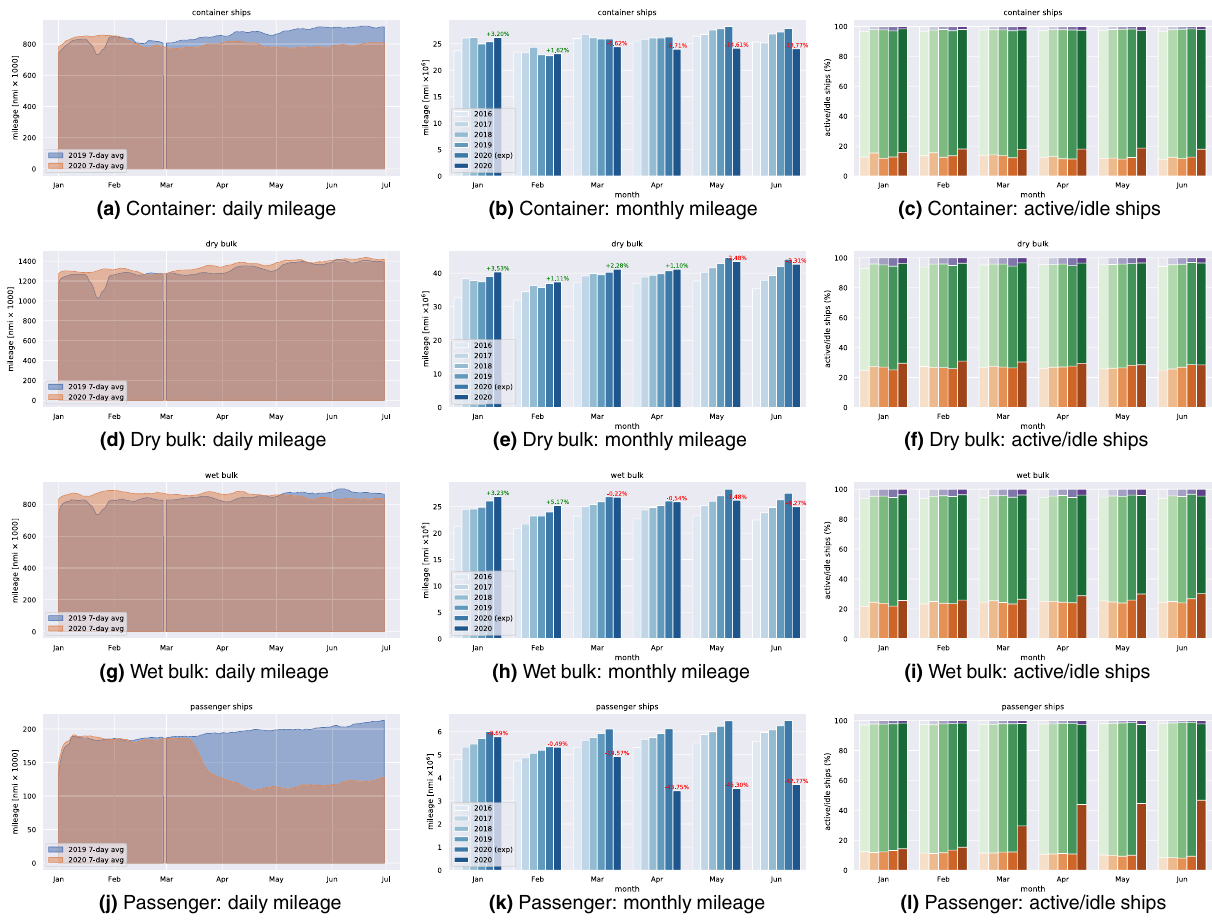
Figure 8. Comparison of traffic indicators for several ship categories: container ( a )–( c ), dry bulk ( d )–( f ), wet bulk ( g )–( i ), and passenger ( j )–( l ). The left column shows daily navigated miles in 2019 (in blue) compared with 2020 (in orange); the two area charts are overlaid in transparency to highlight trend differences; the discontinuity in the blue data series corresponds to the leap day absence in 2019. The mid column shows monthly navigated since 2016 up to 2020; the second last bar in each group represents an estimation of navigated miles in 2020 given the growth rate observed in the previous years; the label on the 2020 bar quantifies the percentage increase or decrease w.r.t. the expected 2020 traffic volume. The last column shows the distribution of active (green) and idle (orange) ships over time, compared with past years, arranged by month with bars from left (2016) to right (2020); purple bars represent the (negligible) part of ships that could be labeled neither as active nor